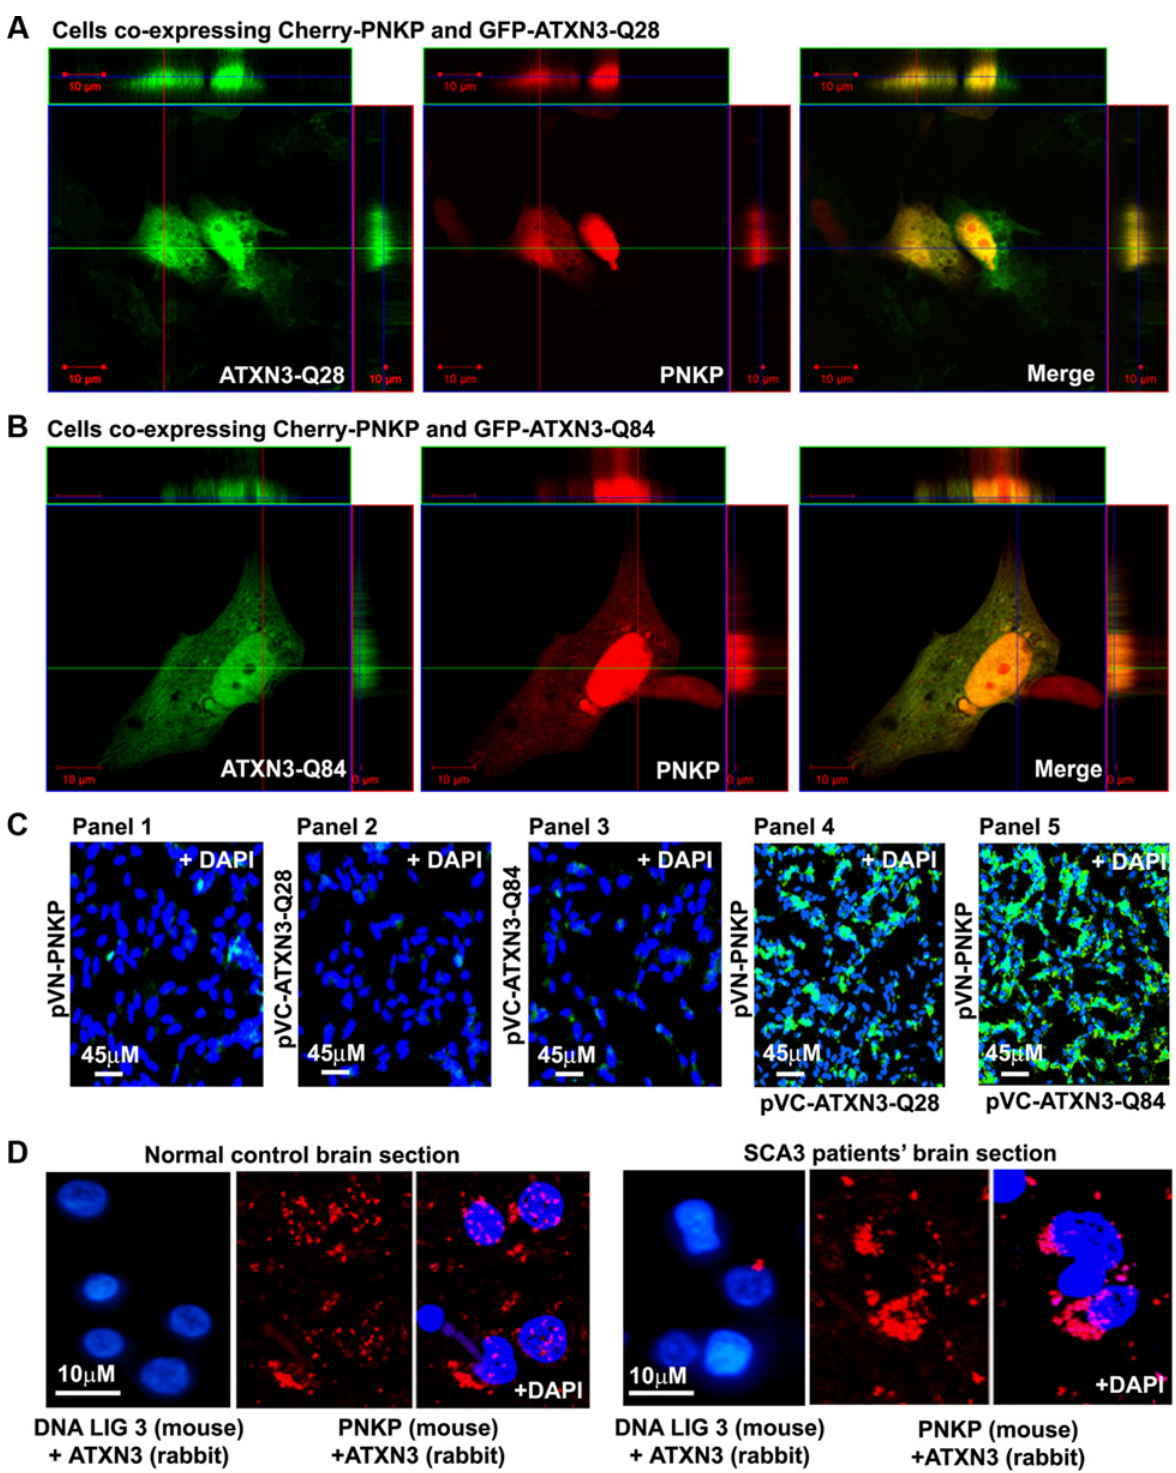
Figure 1. PNKP interacts with both wild-type and mutant ATXN3 in cells and human brain sections. (A) Plasmids pGFP-ATXN3-Q28 and pCherry- PNKP were co-transfected into SH-SY5Y cells and co-localization of PNKP and ATXN3-Q28 was assessed by confocal microscopy; the merge of green and red fluorescence from ATXN2-Q28 and PNKP, respectively, appears as yellow/orange fluorescence. Nuclei were stained with DAPI in C-D. (B) Plasmids pGFP-ATXN3-Q84 and pCherry-PNKP were co-transfected into SH-SY5Y cells and co-localization of PNKP and ATXN3-Q84 was assessed as in